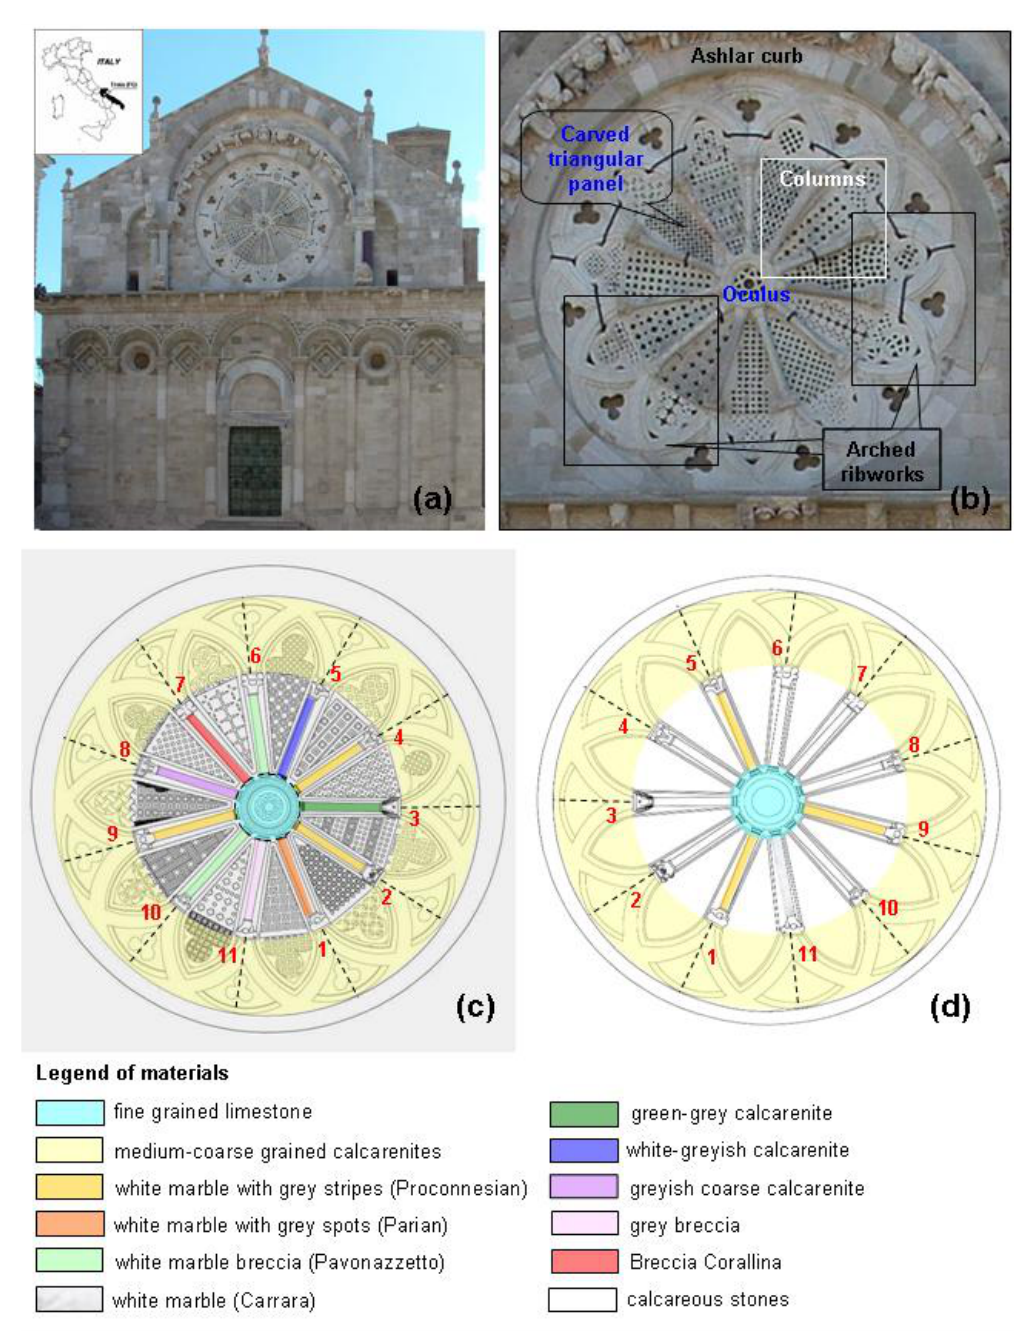
Fig. 1. (a) Fac¸ade and (b) rose window of Troia Cathedral (Apulia, Italy). (c) External and (d) internal building materials.